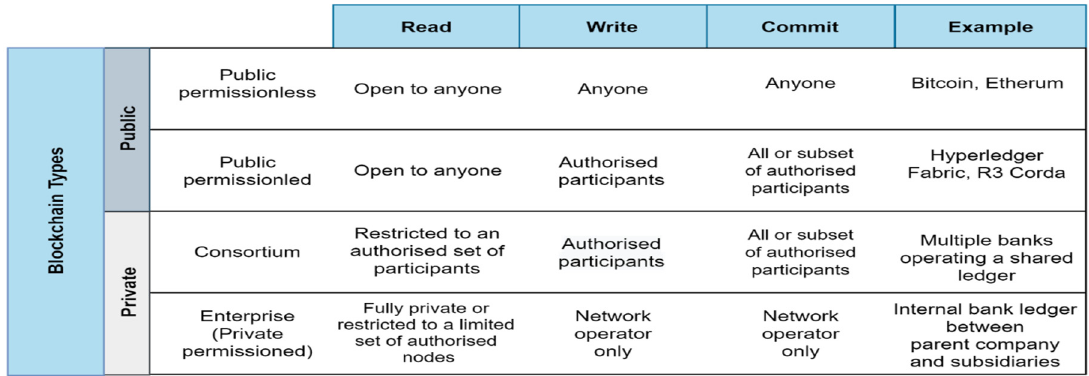
Figure 5. Blockchain Types.